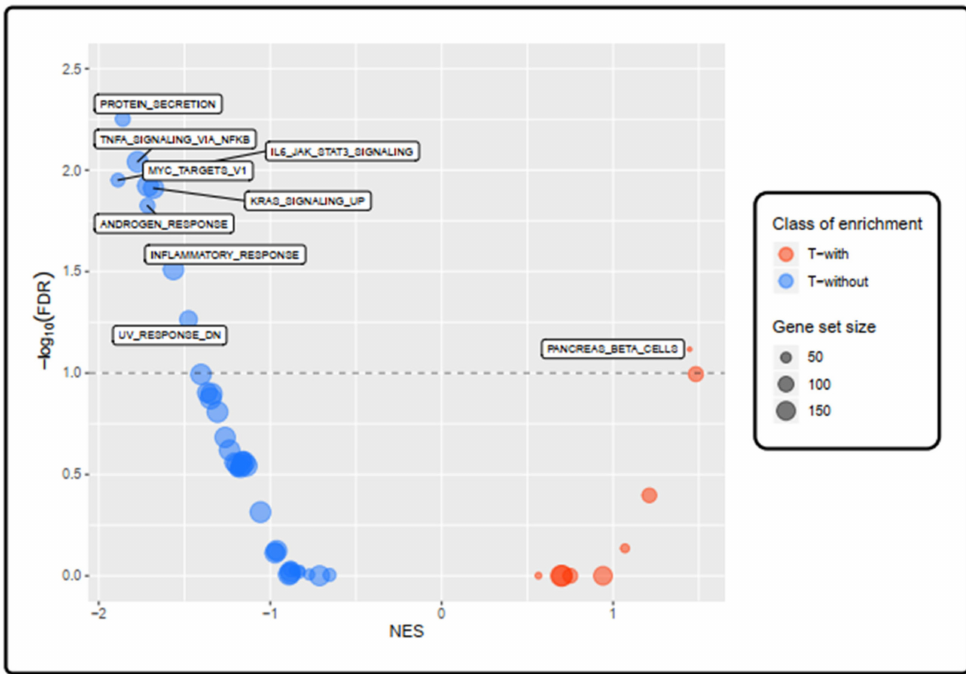
Figure 5. Enriched pathways in T-with tumors compared with T-without tumors: Gene Set Enrichment Analysis (GSEA) Hallmark analysis. Bubble plot showing the enrichment of the Hallmark gene sets between the T-with and T-without groups. Every bubble represents a gene set; the size of the displayed circles is proportional to the number of genes assigned to each term. Red bubbles are gene sets which are more enriched in the T-with group (normalized enrichment score, NES > 0), whereas blue bubbles represent those enriched in the T-without samples (NES < 0). We considered as significantly enriched those gene sets having a False Discovery Rate (FDR) less than 0.1 (10%) and labeled those having a | NES | > 1.4. The higher the y-value of the gene set in the bubble plot (i.e., the smaller its FDR value) and the more extreme its x-value (i.e., NES values), the more the Hallmark gene set is significantly